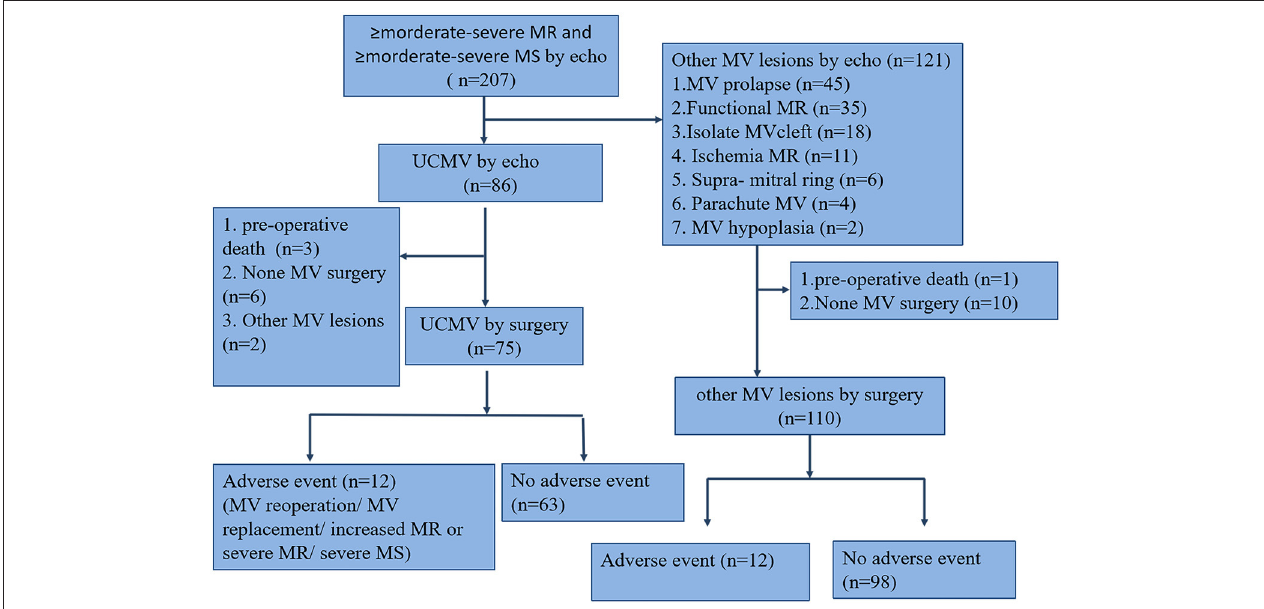
FIGURE 2 | Study population flow chart. The total number of patients with mitral dysfunction was 207. The UCMV and control groups were defined based on mitral valve surgery and echocardiography; other cardiac surgeries and preoperative death were excluded. echo, echocardiography; MV, mitral valve; MR, mitral regurgitation; MS, mitral stenosis; UCMV, undifferentiated chordae tendineae of the mitral